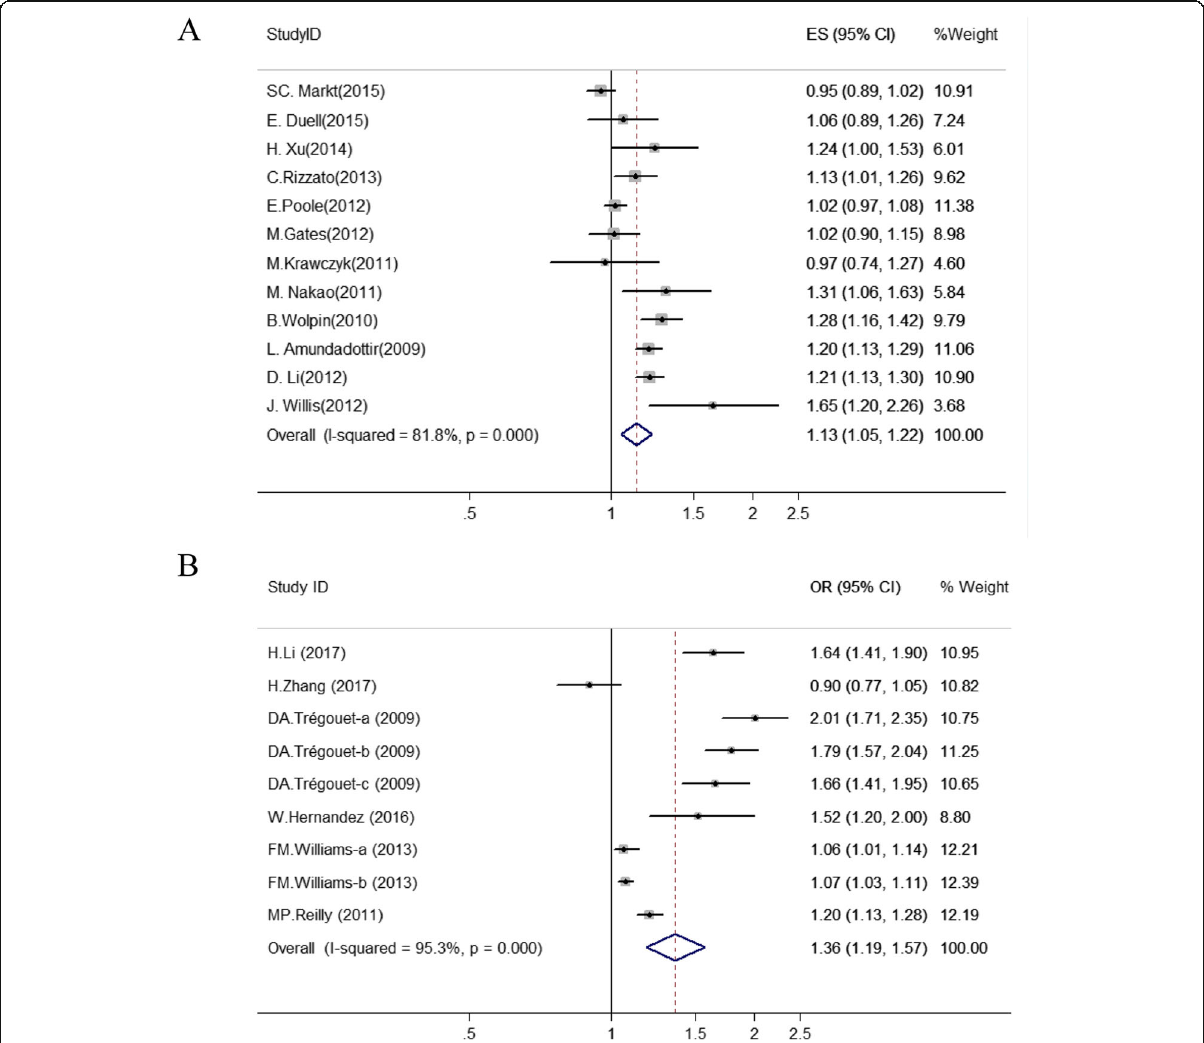
Fig. 2 Forest plot of the relationship between rs505922 polymorphisms and cancer ( a ) and cardiocerebrovascular disease ( b ) risk (allele model and random-effect model). The circle and horizontal lines correspond to OR and 95% CI and the area of the squares reflects the weight of individual studies included in the meta-analysis. The diamond represents the pooled ORs and 95% CI. The dotted red line represents the total OR